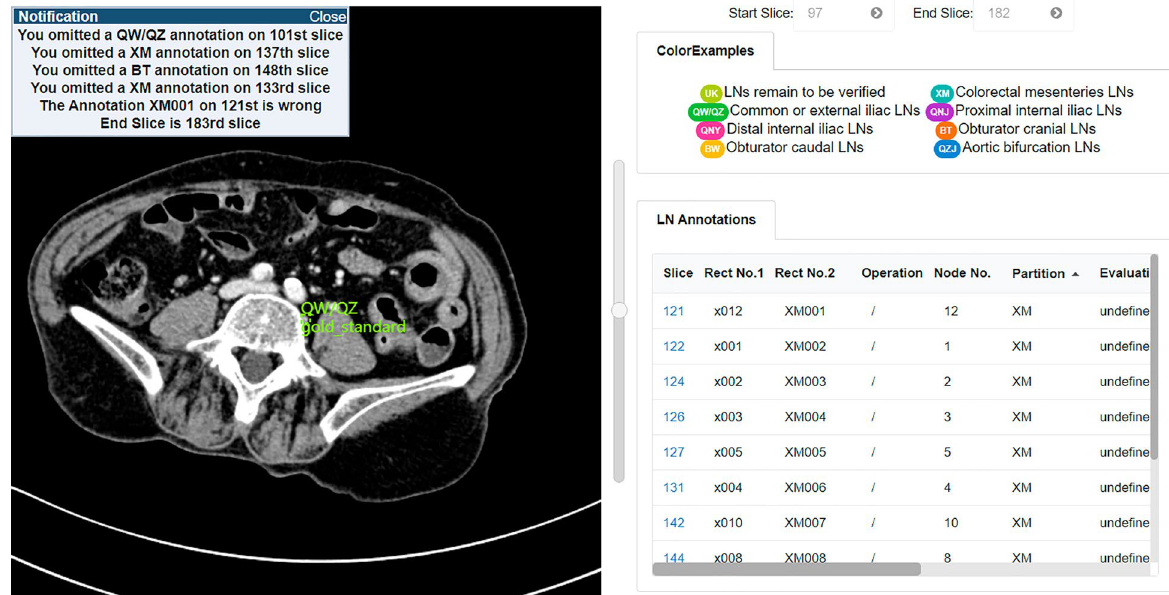
Figure 10. The annotating page of the working interface of junior doctor